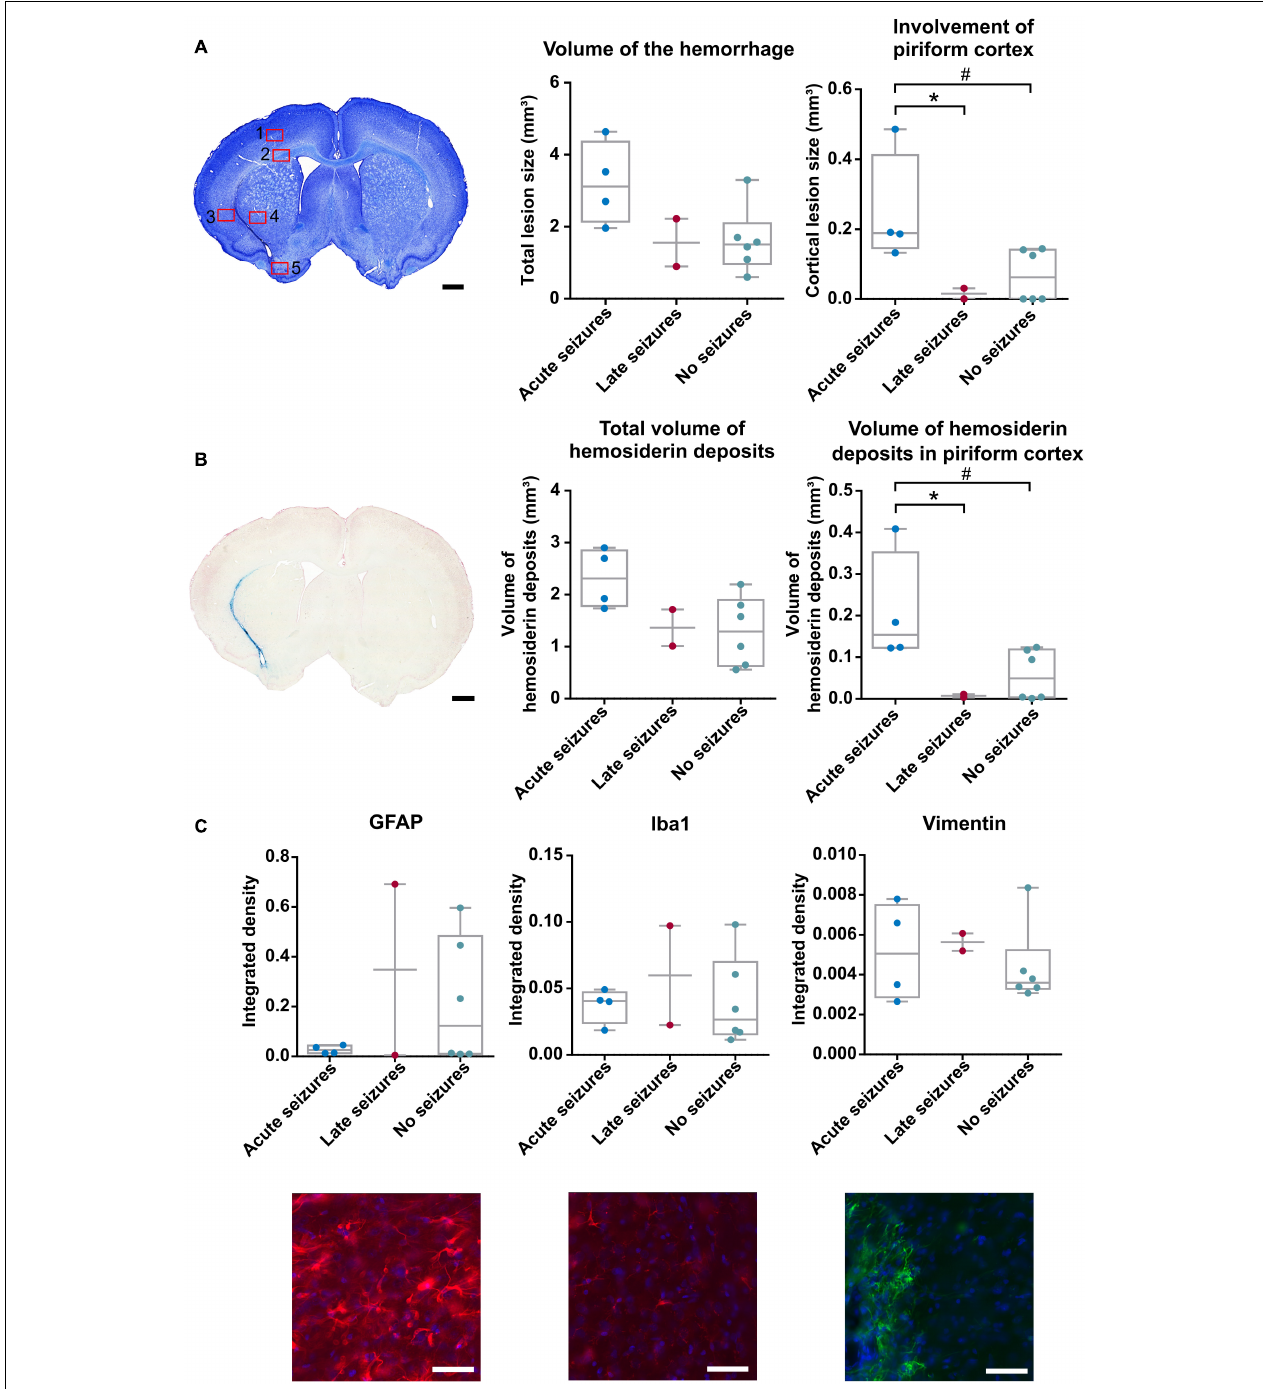
FIGURE 4 | Histology was performed 6 months after ICH induction. (A) Cresyl violet staining of an animal with acute symptomatic seizures (rat 07). Red squares represent the ROIs taken for the immunofluorescence staining. A trend toward a significant difference in lesion volume of the hemorrhage was found between the 3 groups of animals [Kruskal-Wallis test, χ 2 (2) = 4.878, p = 0.087] whereas the involvement of the piriform cortex was significantly larger in the animals with acute seizures [Kruskal-Wallis test, χ 2 (2) = 6.071, p = 0.048; # p = 0.032 (adj p = 0.095); * p = 0.042 (adj p = 0.125)]. (B) Perl’s Prussian Blue staining of an animal with acute seizures (rat 07). The volume of hemosiderin deposits did not statistically differ in the total brain [Kruskal-Wallis test, χ 2 (2) = 4.878, p = 0.087] but did in the piriform cortex [Kruskal-Wallis, χ 2 (2) = 6.399, p = 0.041; # p = 0.03 (adj p = 0.089); * p = 0.033 (adj p = 0.1)]. (C) Results of the Kruskal-Wallis tests and representative images of the GFAP, IBa1 and Vimentin staining in the striatum in an animal with late seizures (rat 10) [ χ 2 (2) = 0.032, p = 0.984; χ 2 (2) = 0.651, p = 0.722; χ 2 (2) = 0.955, p = 0.620, respectively]. Scalebar for A and B is 1 mm, scalebar for C is 50 µ m.